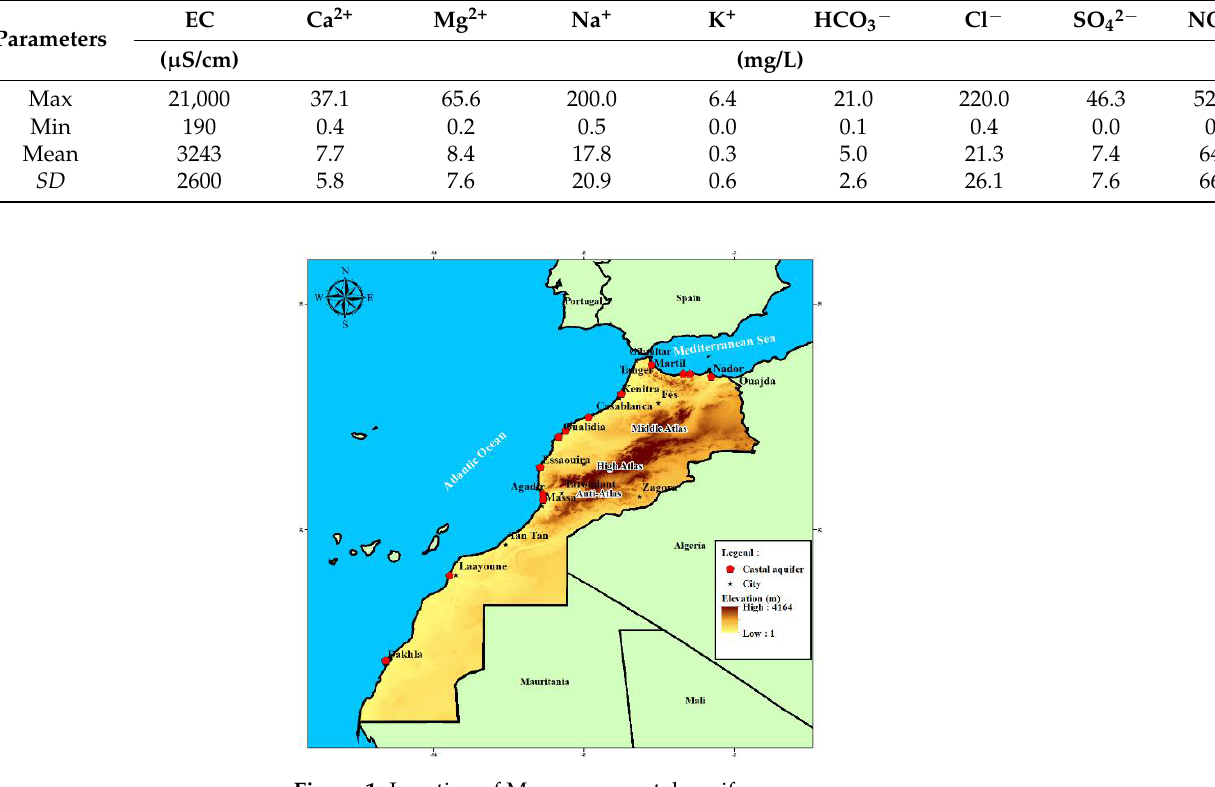
Table 1. Summary of groundwater physico-chemical parameters of Moroccan coastal aquifers ( SD : standard deviation).